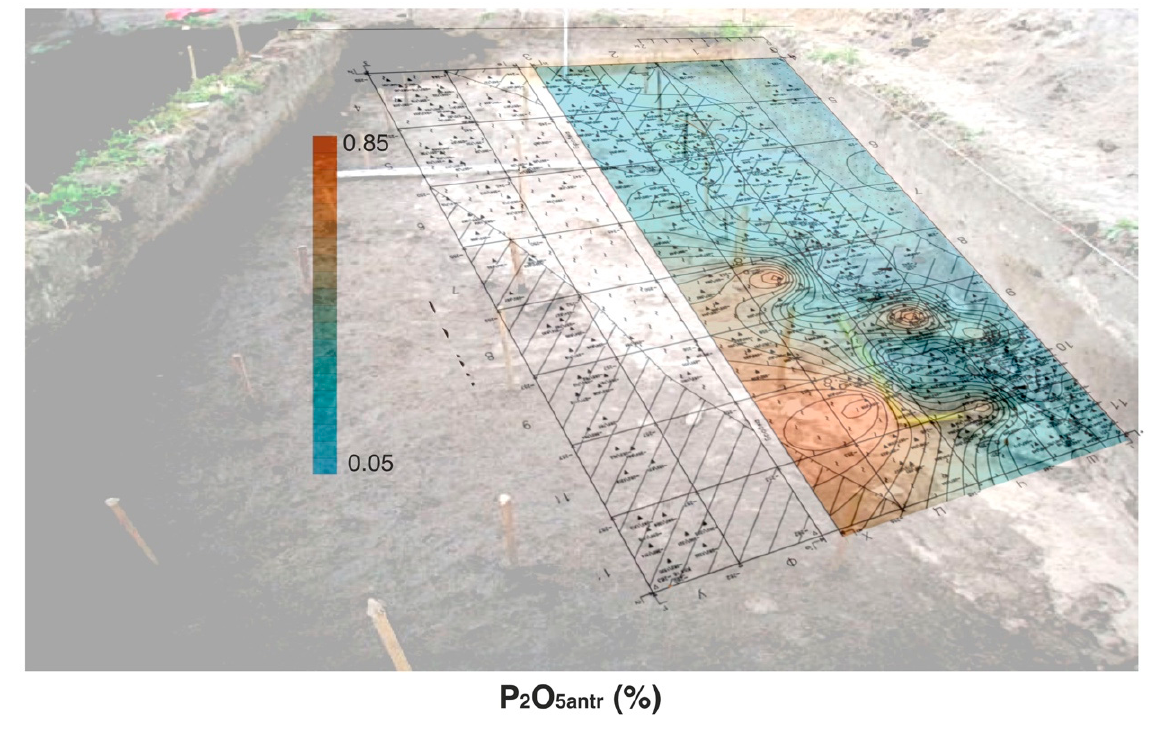
Figure 7. Geochemical maps of P 2 O 5anthr distributions in sediments on the surface of the cultural layer at the Podolye 1 site [38], designed by M.Kulkova.